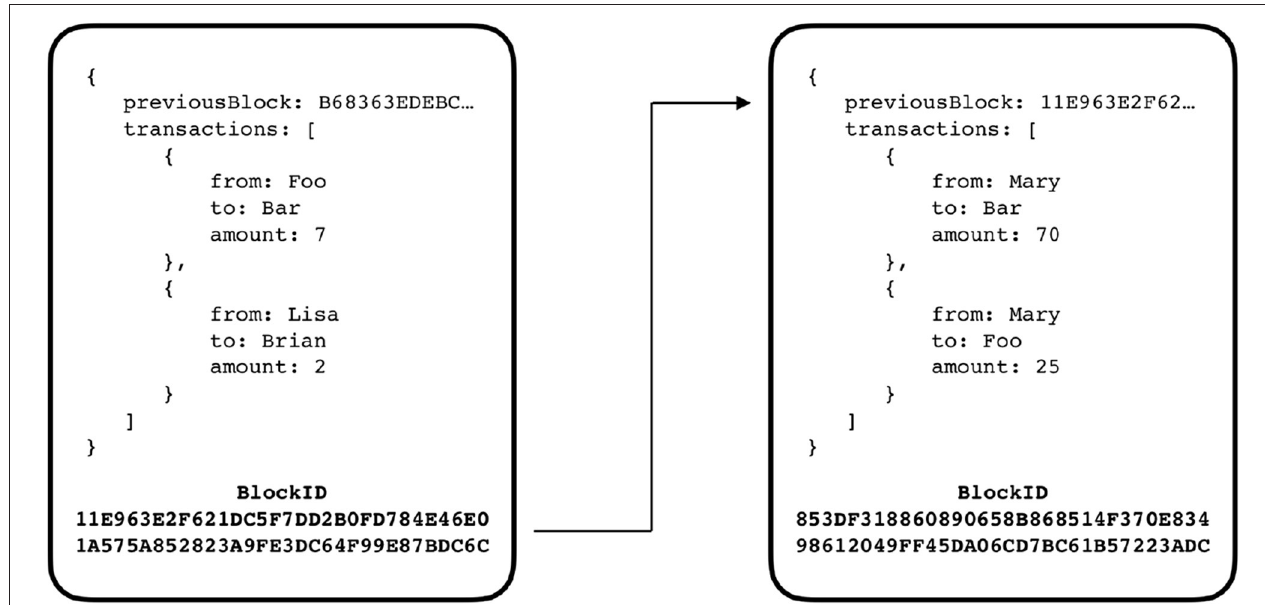
FIGURE 2 | A diagram for illustrating the connection between two blocks of a blockchain. Note that the connection between the blocks is no more than referencing the ancestor block id. As shown, the block on the right, references the block on the left by storing its block id on the previousBlock